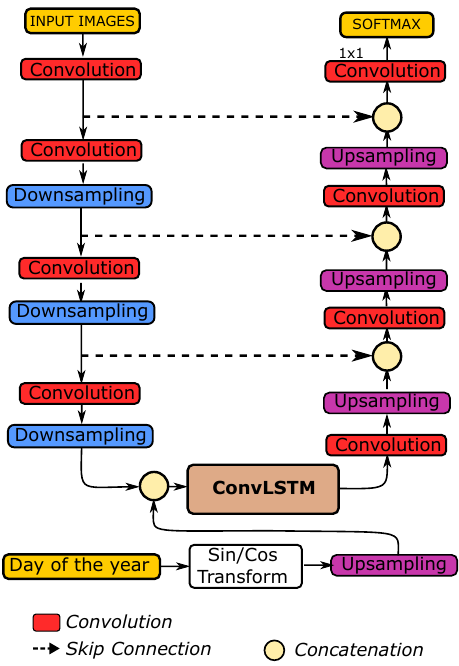
Figure 3. Modified UnetConvLSTM architecture, with the images’ day of the year as additional input. The output corresponds to the class probabilities predicted for each pixel location in the last image.